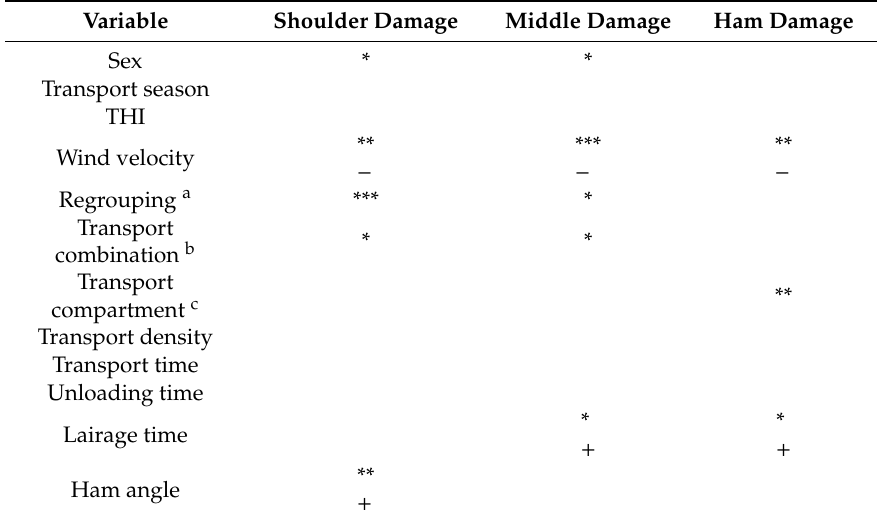
Table 4. Factors influencing the incidence of skin damage. The dependent variables are shoulder, middle, and ham damage. For continuous variables, the direction of the relationship ( + or − ) is